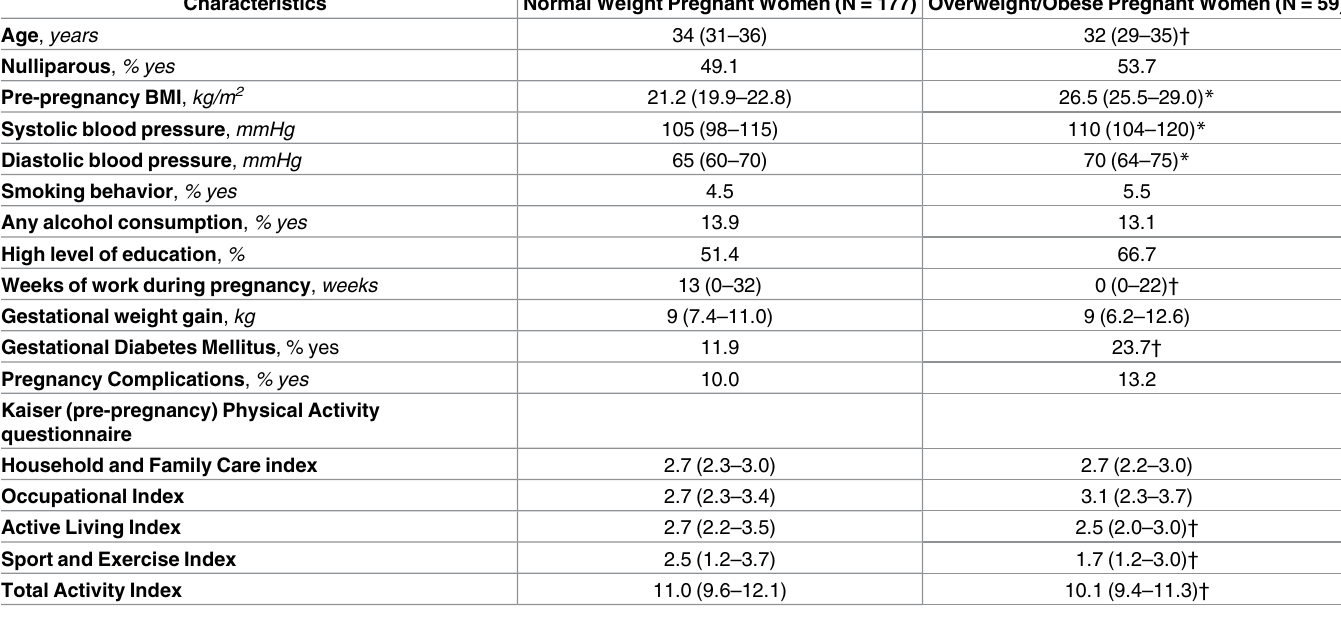
Table 1. Main characteristics of normal-weight and overweight/obese pregnant women enrolled in the study. Values are median (IQR) or percentage.